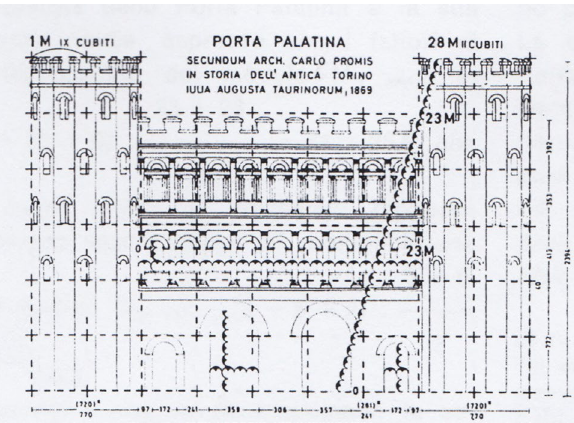
Figure 9 . Graphical analysis, with a comparison – on the current survey – between the modular scheme set on cubits (Kurent) and the one set on feet © M.